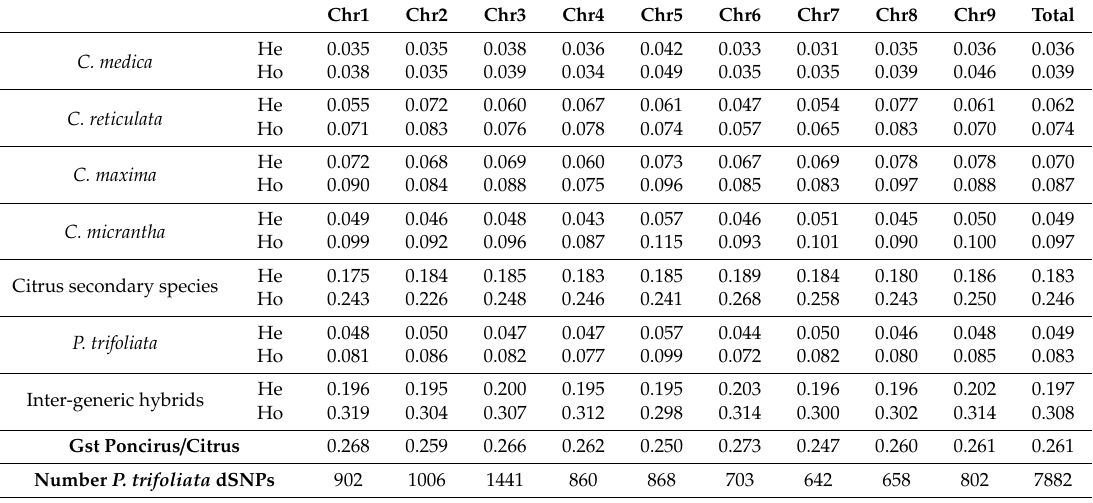
Table 1. Diversity of the Citrus and Poncirus ancestral